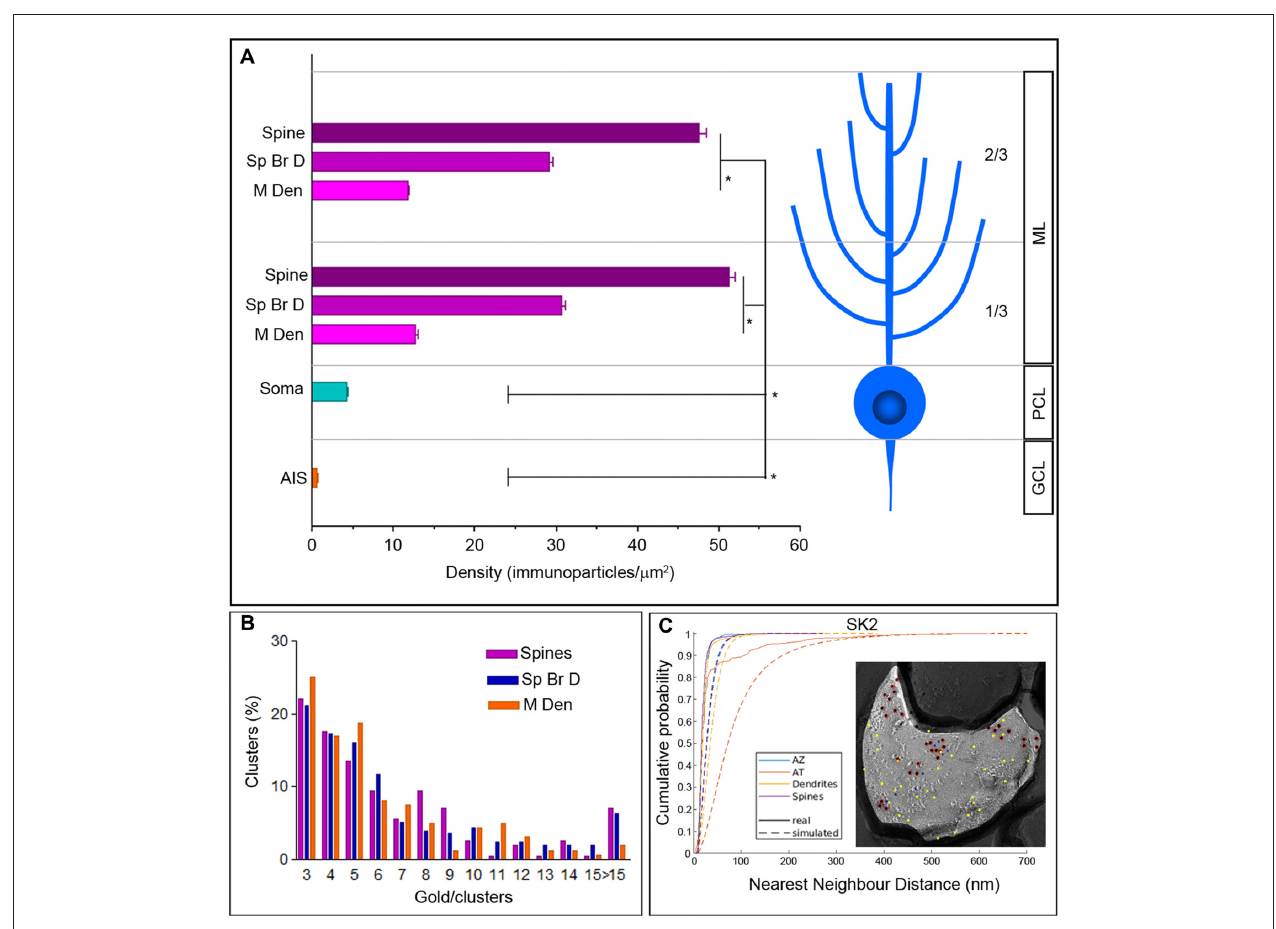
FIGURE 2 | Density gradient of SK2 immunoparticles in the surface of PCs. (A) Bar graph shows the density (mean ± SEM) of the SK2 channels in eight compartments of PCs. Density of SK2 immunoparticles increased from soma to dendritic spines (soma = 4.31 ± 0.13/ µ m 2 ; 1/3 ML main dendrite = 12.69 ± 1.96/ µ m 2 ; 2/3 ML main dendrite = 11.77 ± 0.81/ µ m 2 ; 1/3 ML spiny branchlet dendrite = 30.67 ± 3.11/ µ m 2 ; 2/3 ML spiny branchlet dendrite = 29.14 ± 2.69/ µ m 2 ; 1/3 ML spines = 51.23 ± 2.78/ µ m 2 ; 2/3 ML spines = 47.60 ± 2.69/ µ m 2 ; Kruskal–Wallis test, pairwise Mann–Whitney U test and Dunns method, ∗ p < 0.001). Immunoparticle density for SK2 channels on the AISs was not significantly different from the background (AIS = 0.64 ± 0.02/ µ m 2 ; background = 0.62 ± 0.03/ µ m 2 ). ML, molecular layer; PCL, Purkinje cell layer; GCL, granule cell layer. (B) The graph shows the quantification for the number of SK2 particles per cluster in the spines, spiny branchlets (Sp Br D) and main dendrites (M Den). Approximately 76% of clusters in dendritic spines and spiny branchlets and 81% in main dendrites were in the range of 3–8 immunoparticles. (C) Cumulative probability plots of SK2 to SK2 NND. Real and simulated SK2 are shown by solid and dotted lines, respectively. AZ, active zone; AT, axon terminal. The EM image is an example that show random simulation of SK2 immunoparticles in a dendritic spine. Red, real SK2; Yellow, simulated SK2; blue, real Cav2.1.